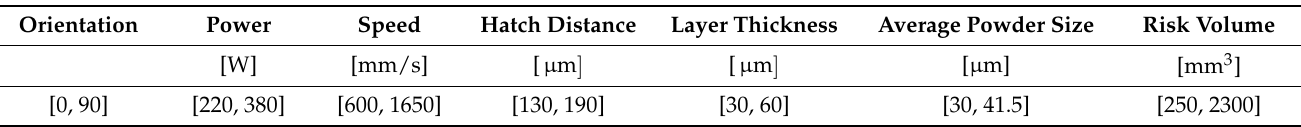
Table 1. Range of process parameters for the datasets on AlSi10Mg considered for the validation of the developed ML